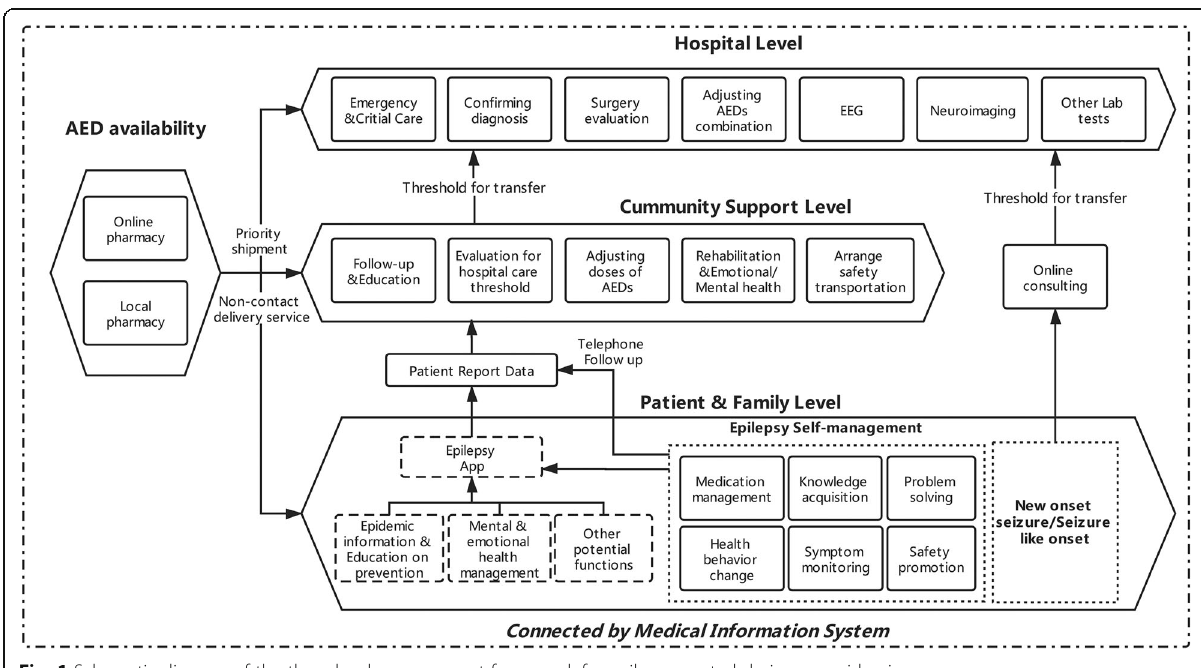
Fig. 1 Schematic diagram of the three-level management framework for epilepsy control during an